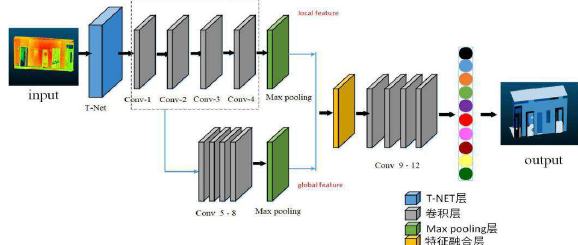
Figure 3. The Structure of